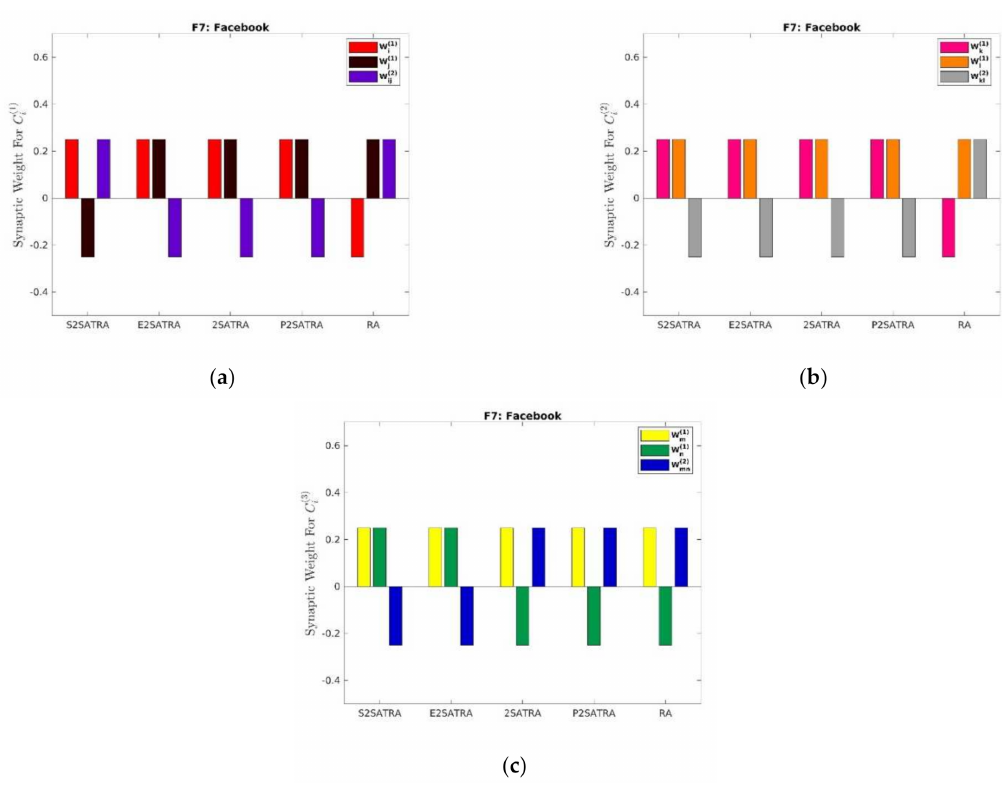
( 1 ) ( 2 ) ; ( b ) C and ( c ) C i i